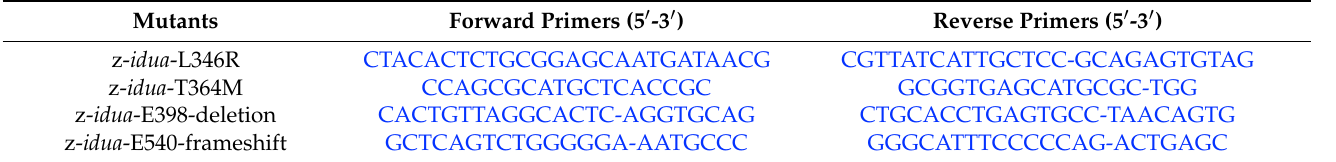
Table 1. The primers used for site-directed mutagenesis of zebrafish idua . Mutants Forward Primers (5 (cid:48) -3 (cid:48) ) Reverse Primers (5 (cid:48) -3 (cid:48)